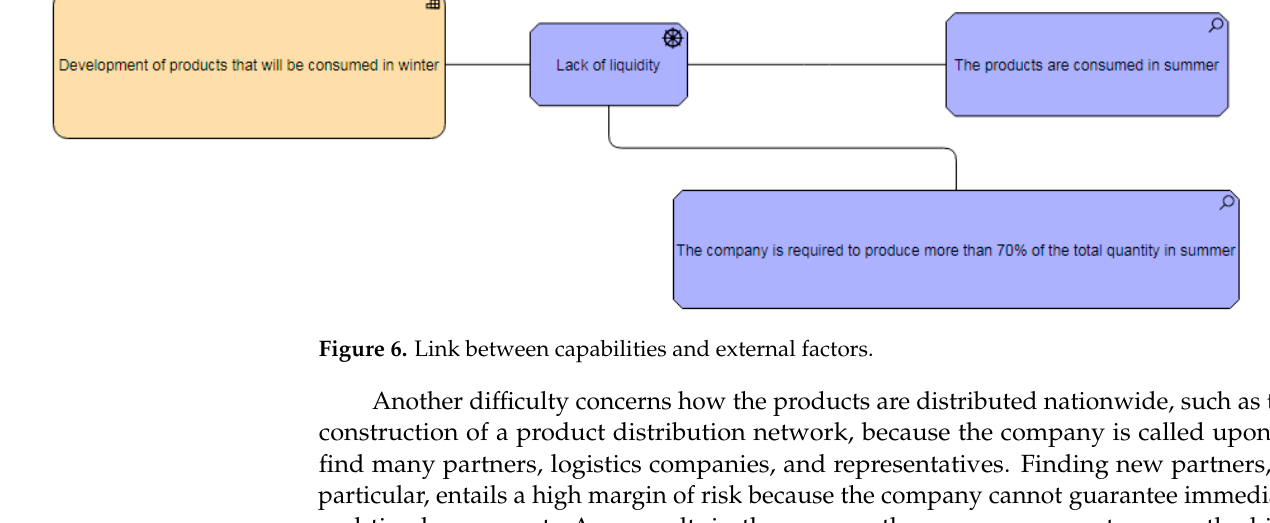
Figure 5. Analysis of external factors and technology.